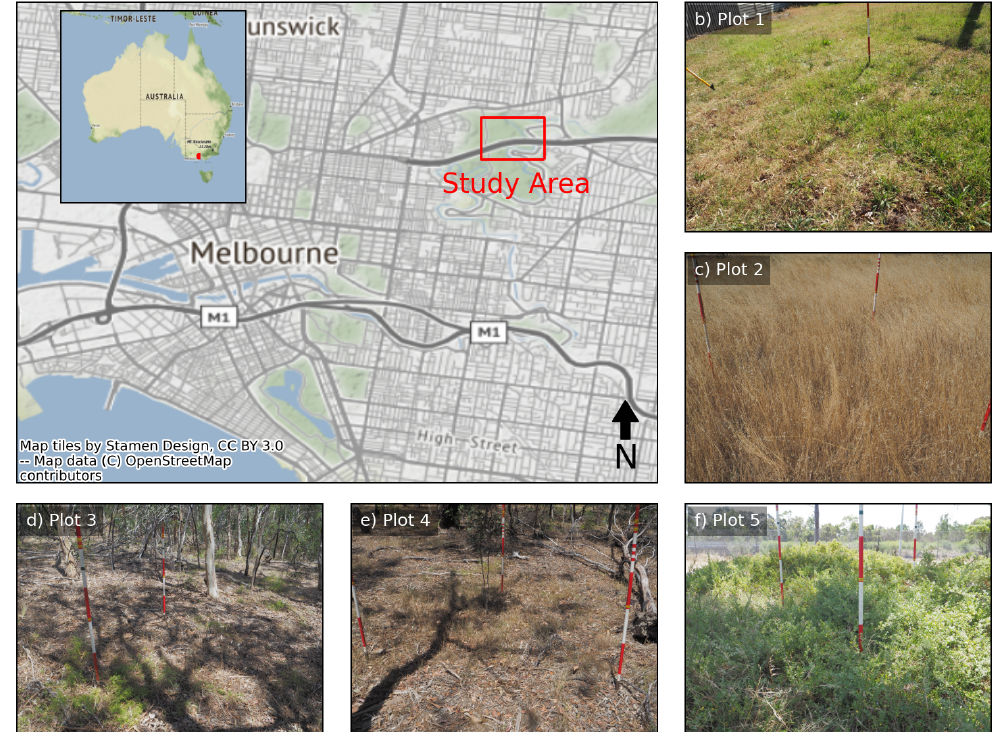
Figure 1. The location of the study area ( a ) and the five plots used to demonstrate the utility of image-based point clouds for measuring the 3D properties of near-ground vegetation in ( b ) manicured turf, ( c ) native tall grass, ( d , e ) dry schlerophyll forest, and ( f ) low shrub